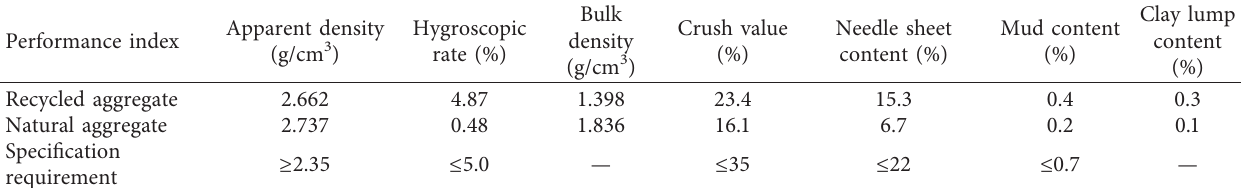
Table 2: Test results of properties of recycled coarse